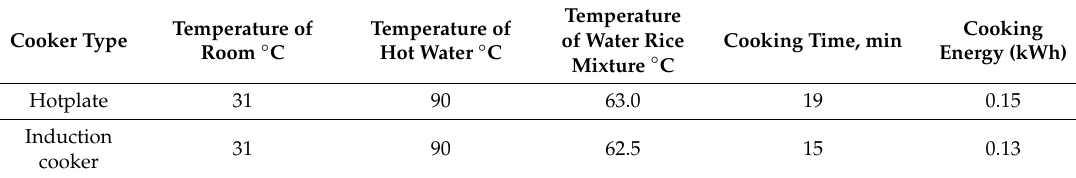
Table 5. Experimental data of cooking while using hot water (with insulated pan cover). Cooker